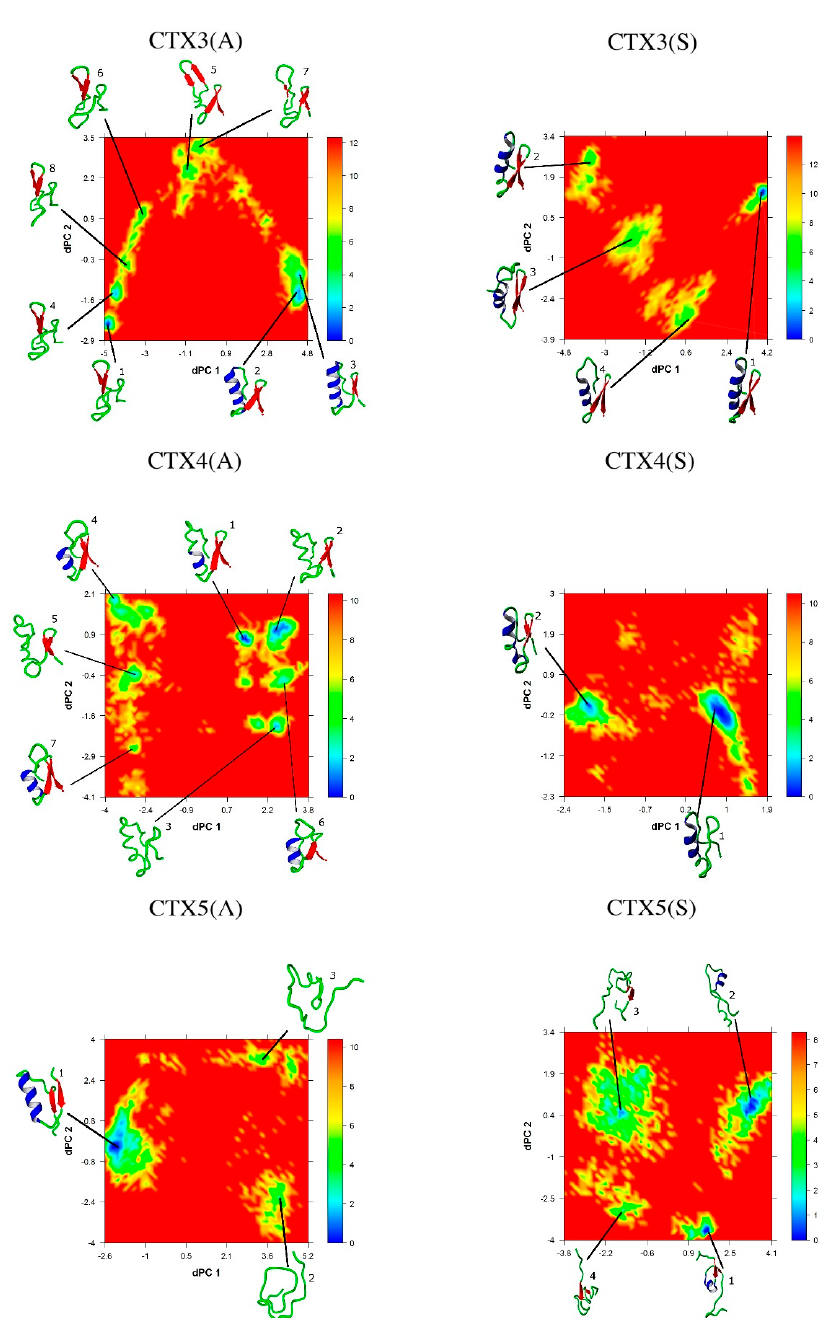
Figure 5. The free energy landscape (kJ · mol –1 ) as a function of the first two dihedral principal components (dPC1 and dPC2). The lowest energy conformations, as determined by cluster analysis, are shown and numbered in order from lowest to highest relative energy. The conformations have been rotated to optimally display the secondary structure elements and interactions. Secondary structure elements show as: red β -sheet, blue α -helix, and green turn/bend/coil.